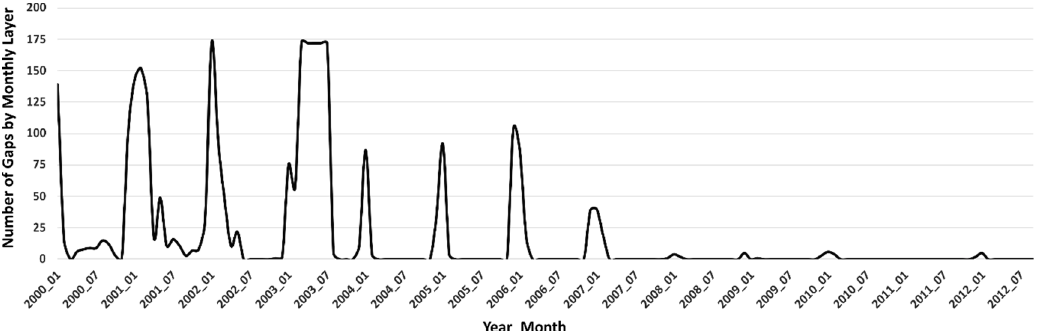
Figure 3. Distribution of gaps during the study period in monthly steps; each number represents the quantity of pixels without data, out of 741 pixels in the region of interest.